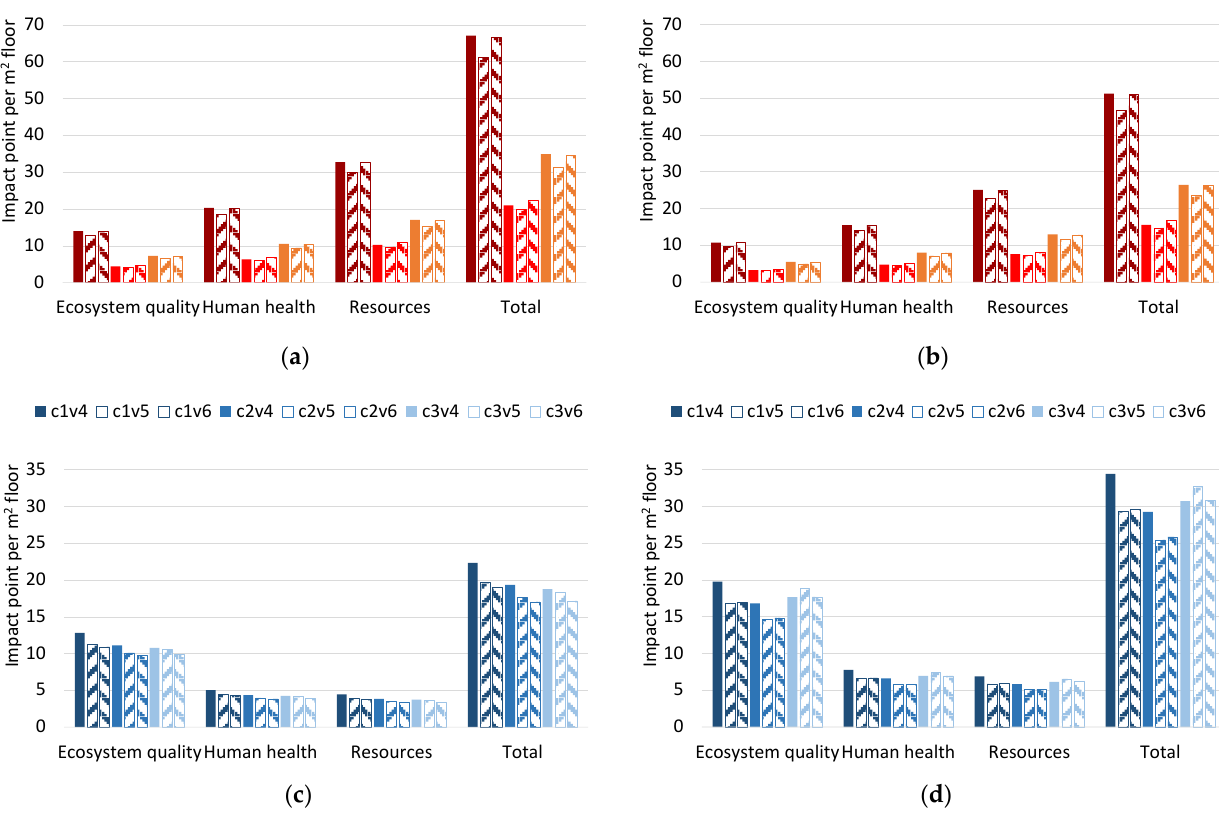
Figure 5. Comparison of the results per m 2 of floor area during the operational stage using the indicator ReCiPe calculated: For heating with ( a ) LCA b ; and ( b ) LCA cc ; and for cooling with ( c ) LCA b ; and ( d ) LCA cc .